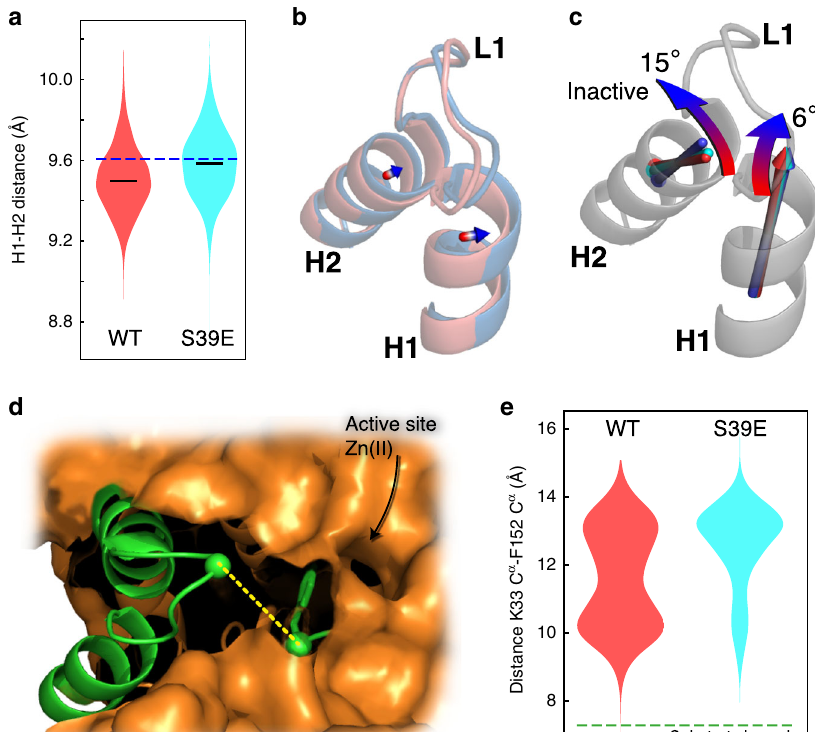
Fig. 4 Structural changes between active and inactive HDAC8 from molecular dynamic simulations. a Distribution of the distance between the centre- of-masses of helix1 (H1) and helix2 (H2) for wild-type HDAC8 (left, red) and S39E-HDAC8 (right, cyan). b Movement of helix1 and helix2 of active wild- type HDAC8 (red) compared to the crystal structure of TSA-bound HDAC8 (PDB: 1t64; blue). c The average orientation of helix1 and helix2 for wild-type HDAC8 (red), S39E-HDAC8 (cyan) and TSA-bound HDAC8. d Distance between loop1 and the substrate-binding tunnel, here assessed by the distance (yellow dashed line) between C α of K33 in loop1 and C α of F152, which forms the wall of the substrate-binding tunnel. e Distribution of distances between K33 C α and F152 C α for the simulation of wild-type HDAC8 (red) and S39E-HDAC8 (cyan). The distance measured for the crystal structure of substrate- bound HDAC8 (PDB: 2v5w) is shown as a green dashed